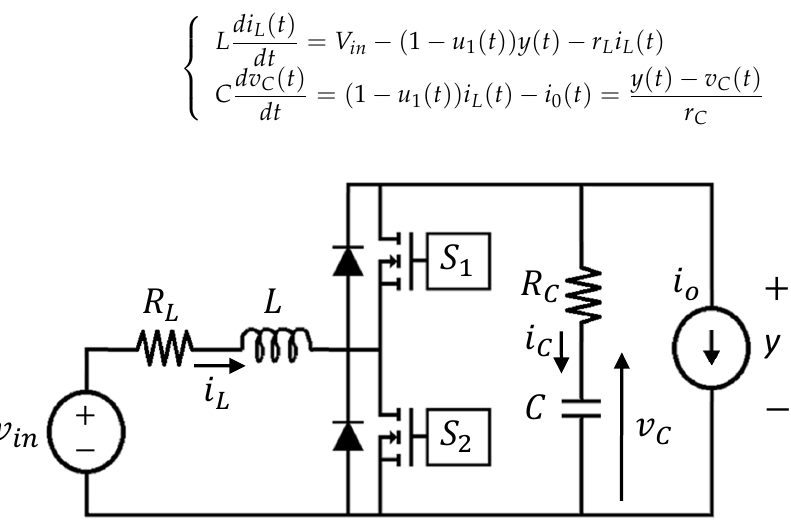
Figure 5. Boost Converter with a variation of load represented by i 0 . Taking the state vector, x ( t ) =